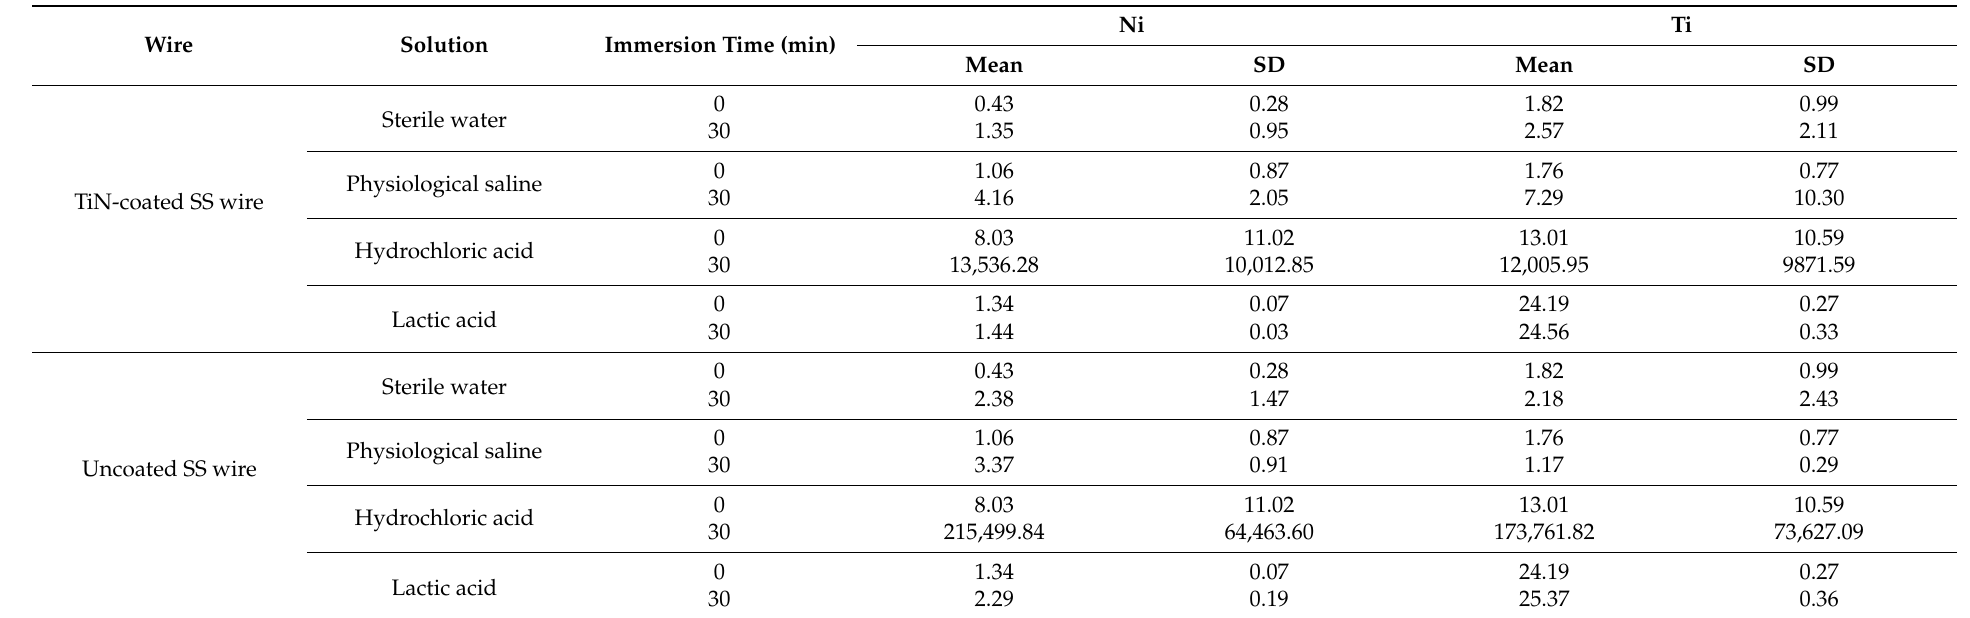
Table 2. Metal ion release from NiTi wire ( µ